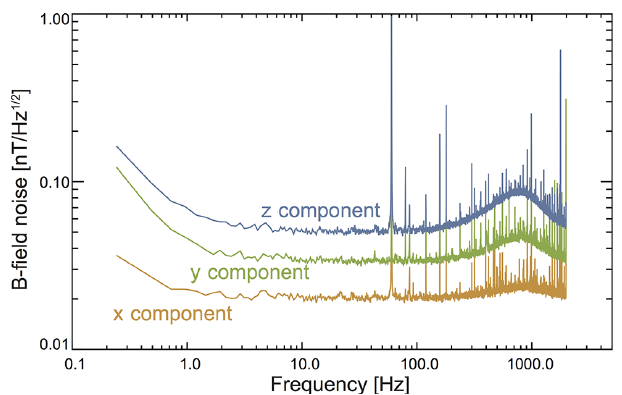
Figure 3. Instrumental noise floors for each vector axis of a Biomed magnetometer.